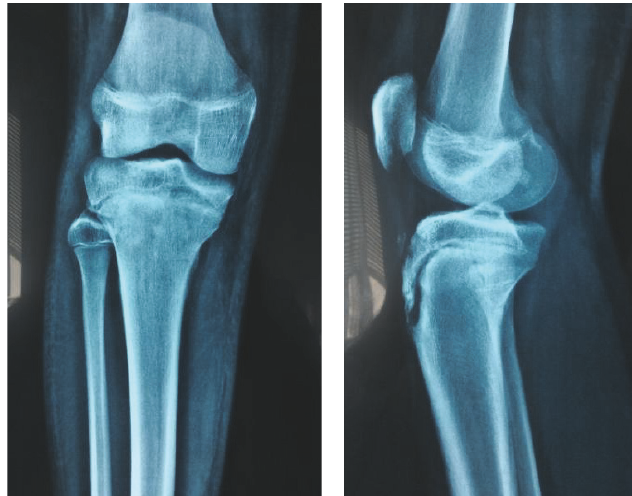
Figure 4: Plain radiographs 6 weeks after reduction.